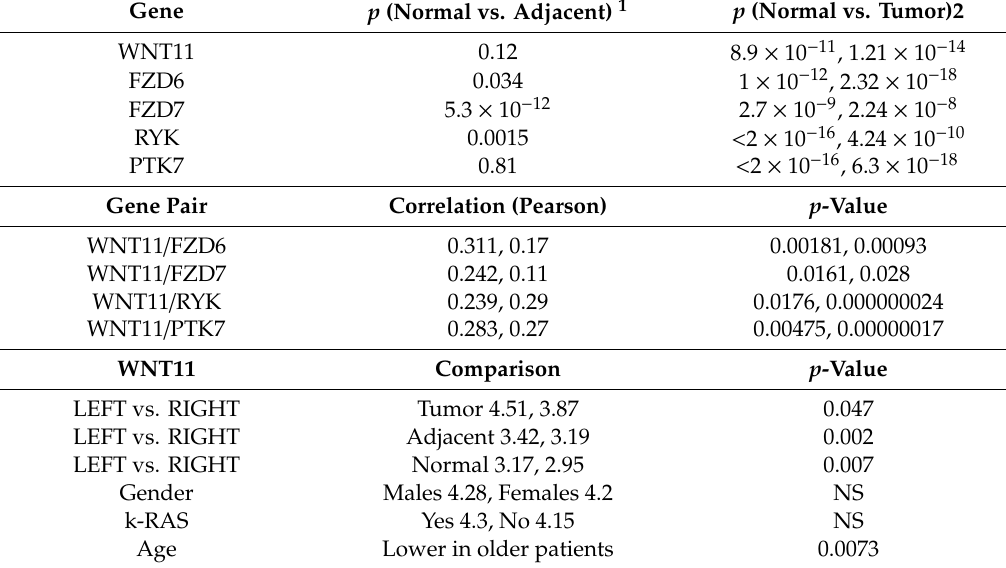
1 normal versus (vs.) adjacent comparison for GSE44076; 2 normal vs. tumor and correlation for GSE44076 (1st value) and TGCA (2nd value); NS, not